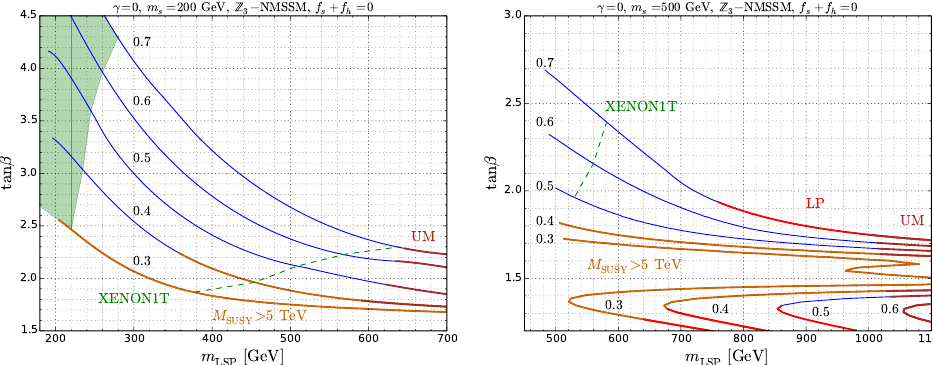
Figure 6 . Contours of (cid:10) h 2 = 0 : 12 in the plane m LSP -tan (cid:12) assuming SI blind spot with m (cid:31) > 0 and (cid:22) > 0 in the Z 3 -invariant NMSSM for several values of (cid:21) with m s = 200 (left panel) and 500 GeV (right panel). The color code is the same as in the right panel of (cid:12)gure 3. The lines denoted by UM depict regions in which NMSSMTools reports unphysical global